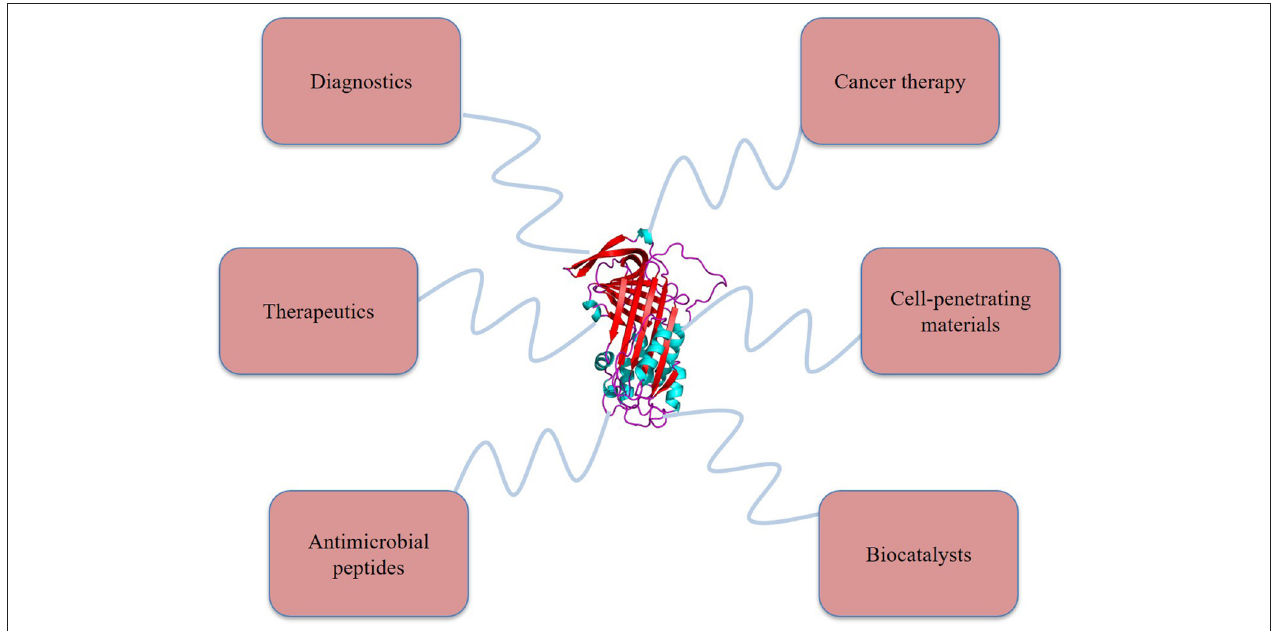
FIGURE 3 | Application of various protein polymer conjugate in the wide spectrum of biomedical